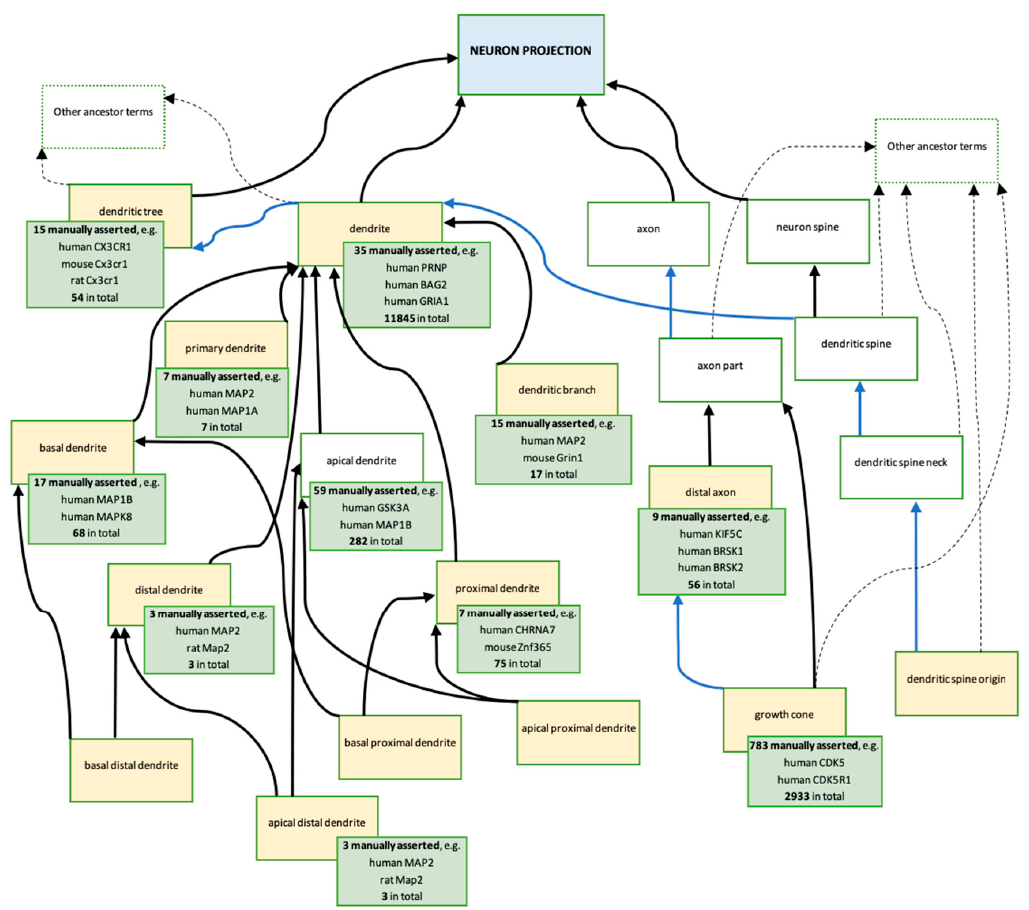
Figure 5. Descendants of cellular component ‘neuron projection’ GO terms created or modified, as a result of this ARUK-UCL project. Ontology: The blue box represents the ancestor term ‘neuron